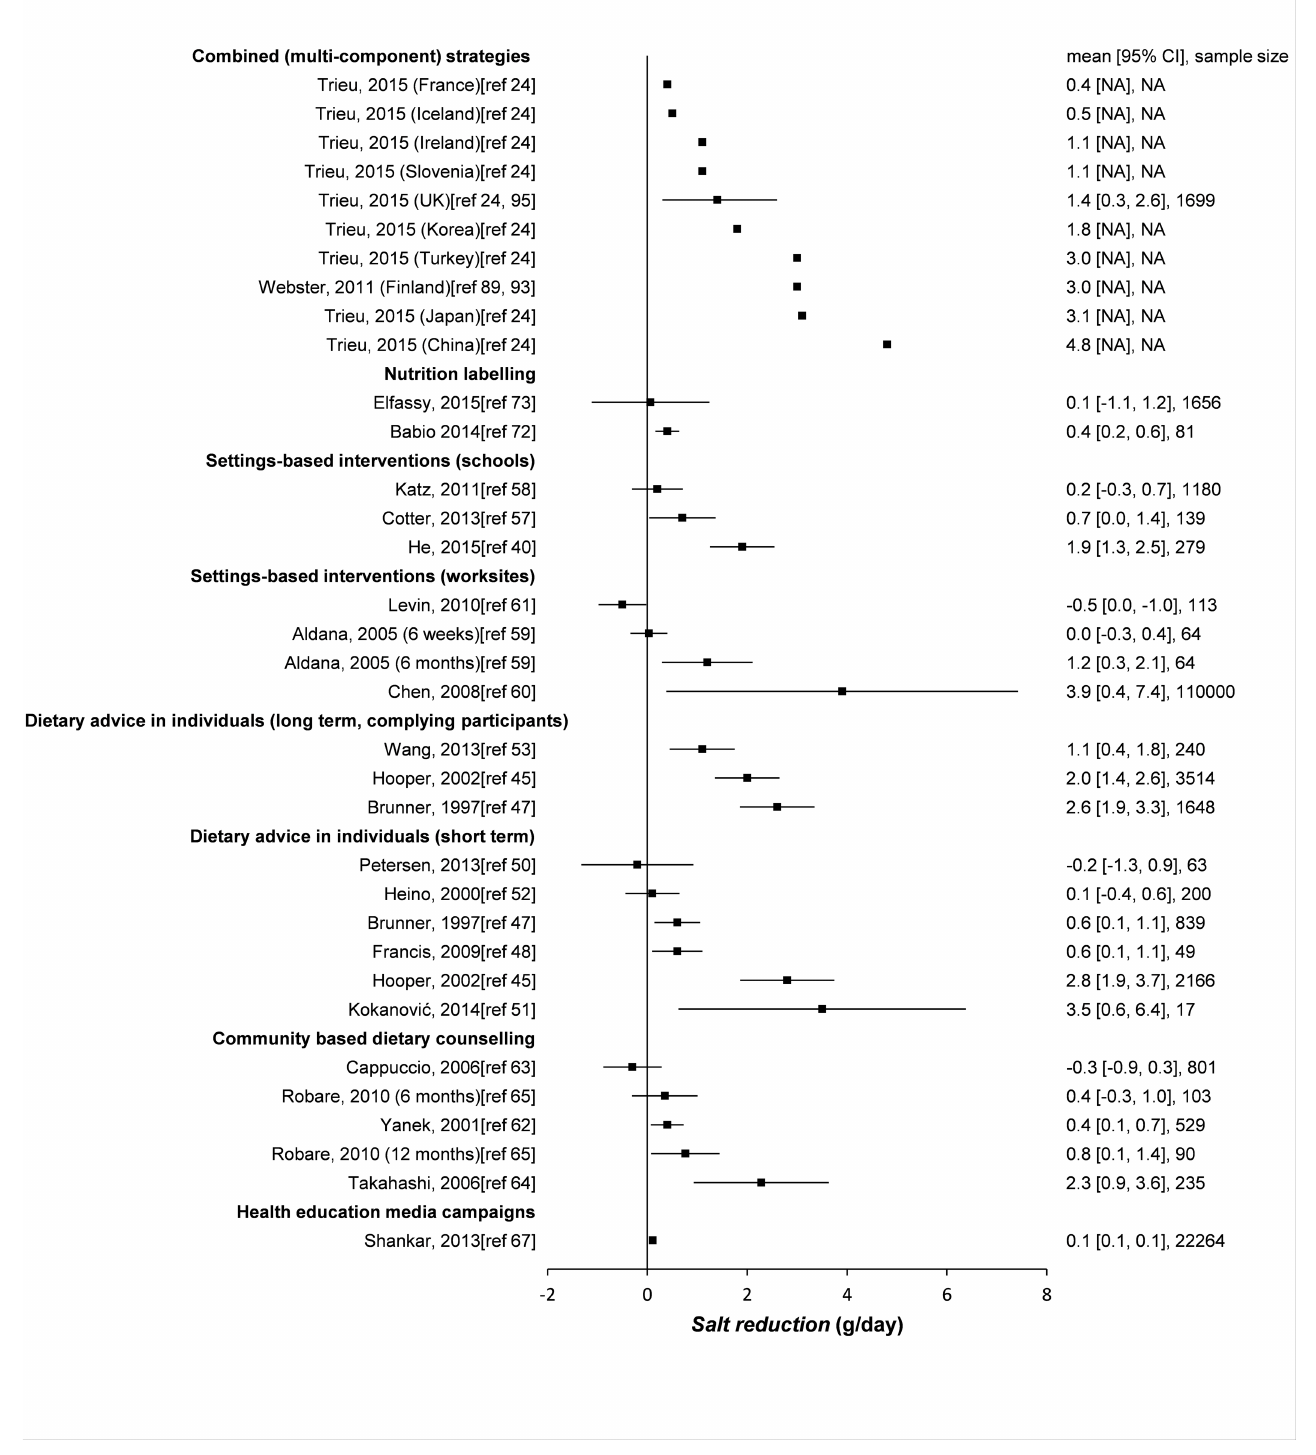
Fig 3. Effectiveness of interventions to reduce salt intake (empirical studies). Forest plot of the empiricalstudies that were includedin this systematic review. Negativevalues of salt reductionare interpretedas reportedincrease in salt consumption.For most combinedinterventions the sample size and confidenceintervalswere not reported. NA denotes not applicableor not